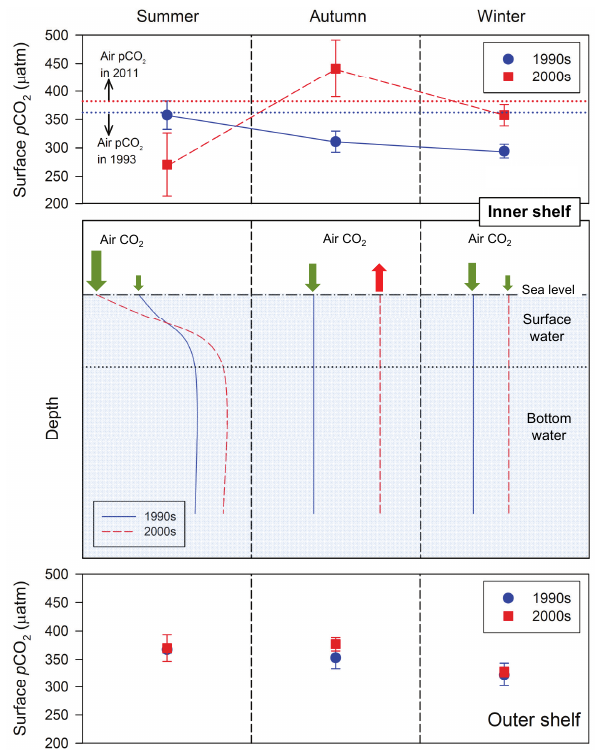
Fig. 6. A conceptual diagram showing the decadal change of sea- sonal variations of p CO 2 and their vertical distributions between the 1990s and the 2000s related to the worsening eutrophication on the inner shelf near the Changjiang Estuary. The dotted line in the middle panel indicates the depth of pycnocline ( P D ), defined as the depth with the steepest vertical gradient in density, based on which the water column was divided into the surface (above the P D ) and the bottom (below the P D )